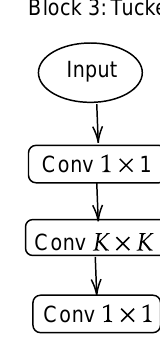
Figure 6. Blocks used in MobileDet.